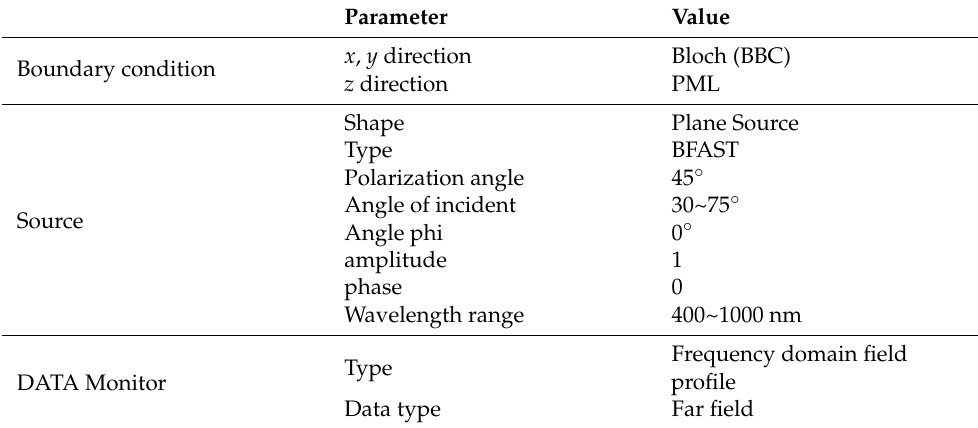
Table 1. FDTD Solutions simulation setup parameter.